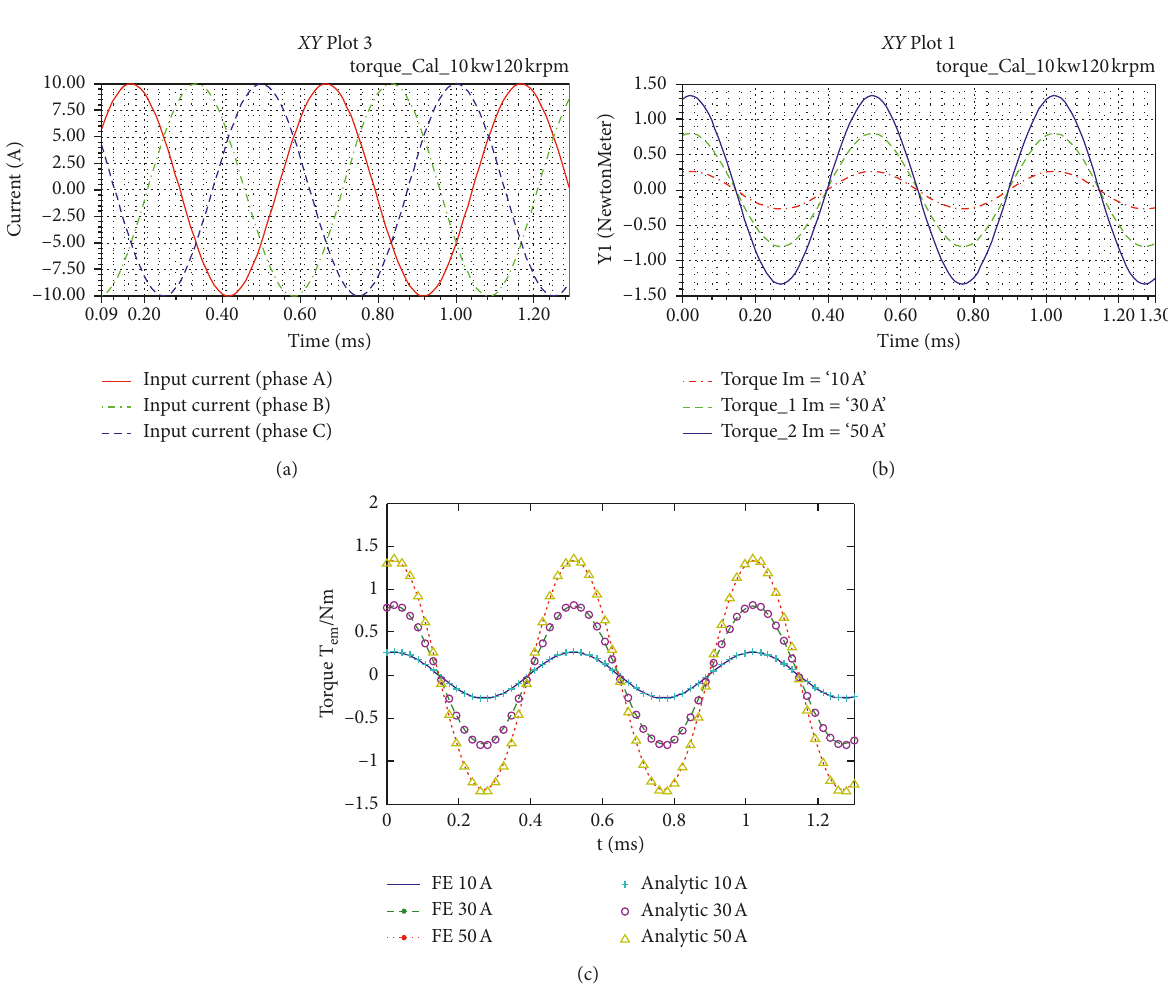
Figure 3: The results of the locked-rotor. (a) The three-phase alternating currents. (b) The torque vs time. (c) Result comparison of FEM and the analytical model. Table 2: Peak torque comparison between FE and the